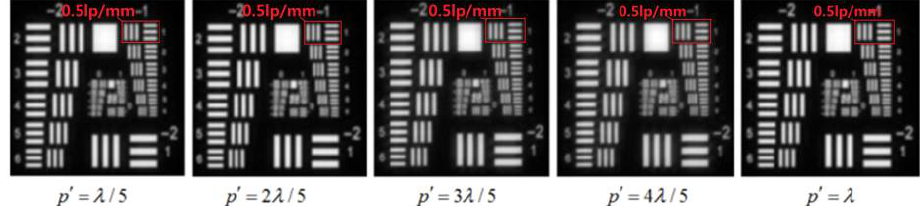
Figure 13. Simulated imaging of piston error correction.